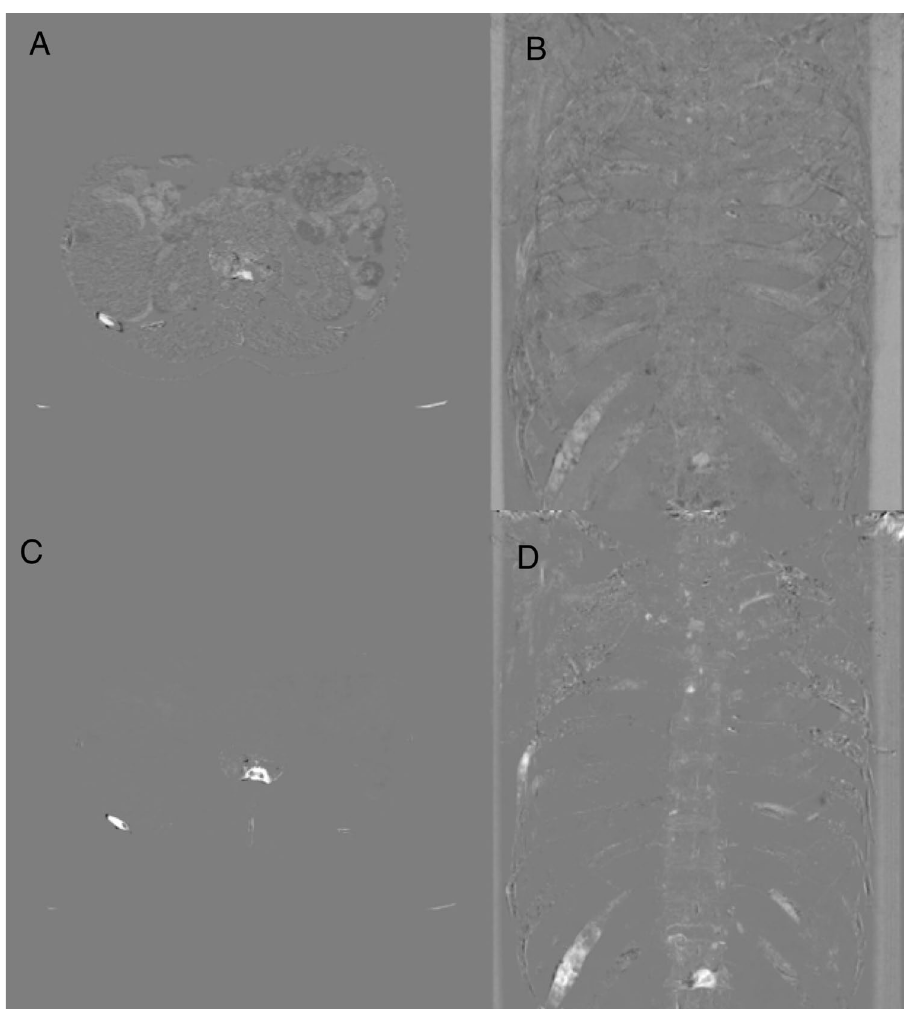
Figure 1. Temporal subtraction (TS) images generated using our TS method and Sakamoto’s TS method. Images are obtained from a 71-year-old female patient with lung cancer who developed multiple osteogenic and mixed bone metastases. ( A , B ) An axial image and a projection image generated using Sakamoto’s method, respectively; ( C , D ) an axial image a projection image generated using our TS method,